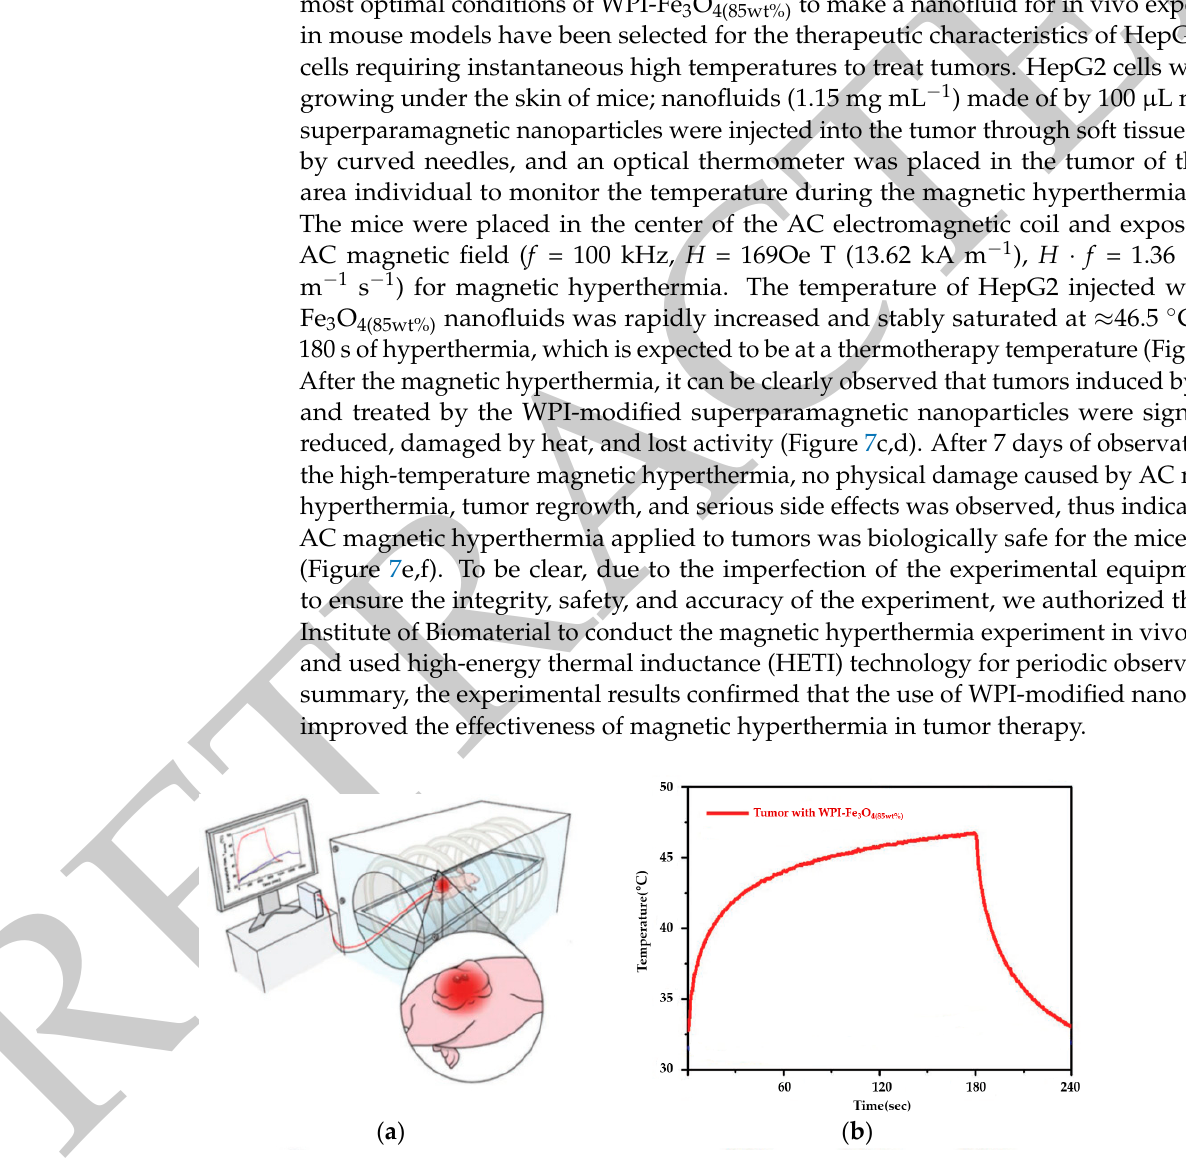
( f ) Figure 7. ( a ) Model of in vivo magnetic hyperthermia with mice carrying HepG2 tumors; ( b ) results of tumor temperature during in vivo magnetic hyperthermia; ( c ) model of high-energy thermal inductance (HETI) equipment for check result of tumor scale after in vivo magnetic hyperthermia; ( d ) set result of tumor scale: the first row using in vivo magnetic hyper- thermia with WPI-Fe 2 O 3(85wt%) . The middle row using treatment with Adriamycin. The bottom row using treatment with normal saline; ( e ) the survival curve of mice at 0 day after magnetic hyperthermia; ( f ) the survival curve of mice at 7 days after magnetic hyperthermia. 4. Conclusions In this study, the water-soluble low-molecule WPI was prepared by hydrolyzing the WPI. Superparamagnetic nanoparticles ( γ -Fe 2 O 3 , Fe 3 O 4 ) prepared by hydrothermal meth- ods were used as tumor-targeting carriers and combined with WPI into bio-modified su- perparamagnetic nanoparticles, which have an average diameter of 20 to 100 nm, crystal particle morphology, good stability, and biocompatibility under various conditions and were successfully loaded with an ideal load of Adriamycin. Due to the biological proper- ties of the WPI, the efficacy of modified nanoparticles in magnetic hyperthermia was im- proved. Various chemical and physical analyses were conducted to verify the structure, morphology, biocompatibility, magnetic properties, and induction heating properties of the newly developed nanoparticles. In vitro and in vivo magnetic hyperthermia studies were conducted using HepG2 tumor and HepG2 mouse models to evaluate its clinical feasibility as a magnetic hyperthermia agent. In summary, the research findings fully prove that WPI-modified superparamagnetic nanoparticles have excellent AC induction